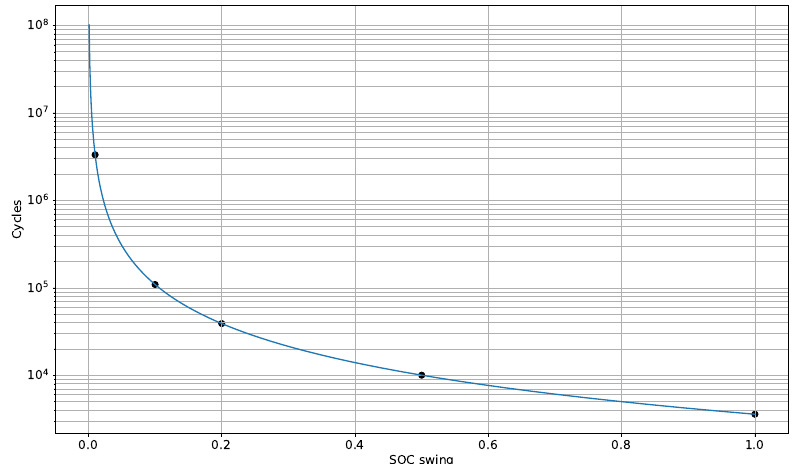
Figure 12. Proposed life curve for the LFP batteries. The dots are at 0.01, 0.1, 0.2, 0.5, and 1.0 SoC